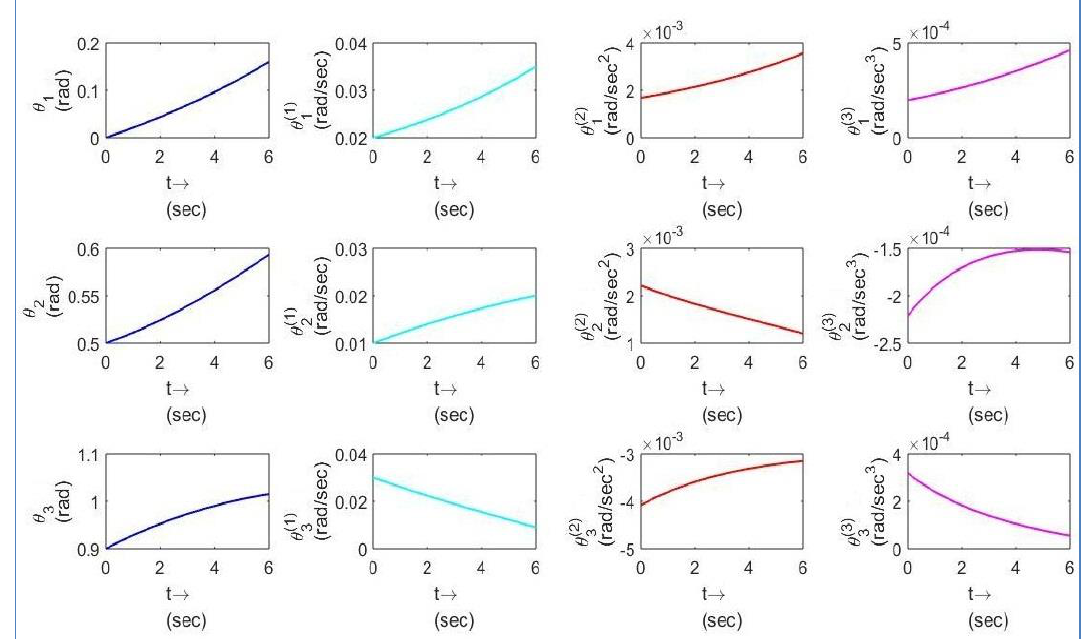
Figure 5. Joint trajectories of the end-effector and their